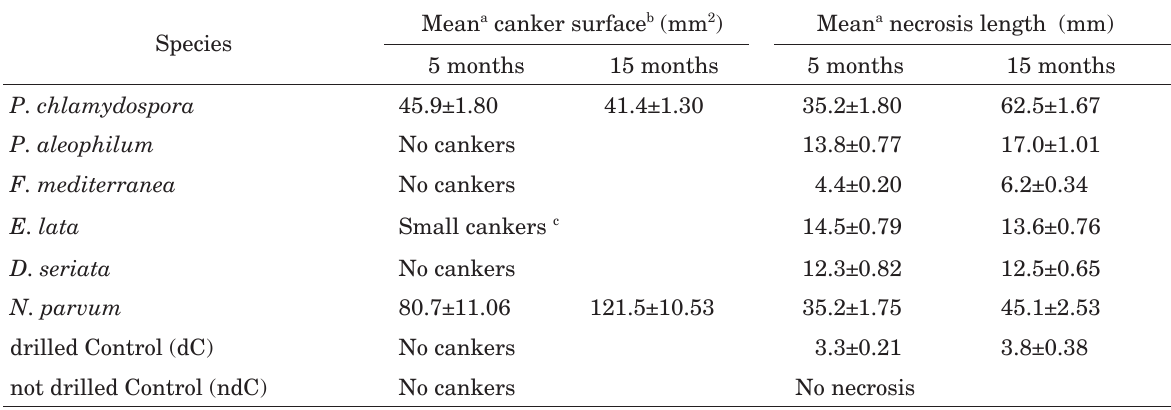
a Data are means of fi ve replicates per treatment ± standard deviation. b Determined using the ellipse formula ( p ab, a=canker length/2, b=canker width/2). c Cankers not measured, observed after inoculation of two isolates (El1 &